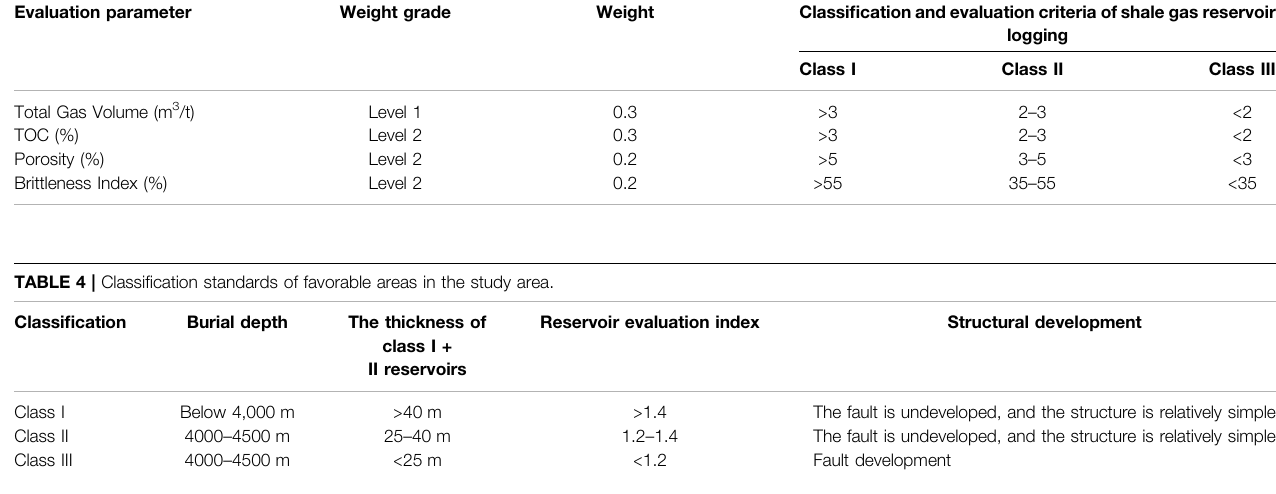
TABLE 3 | Comprehensive evaluation standard of selecting shale gas areas in the study area. Evaluation parameter